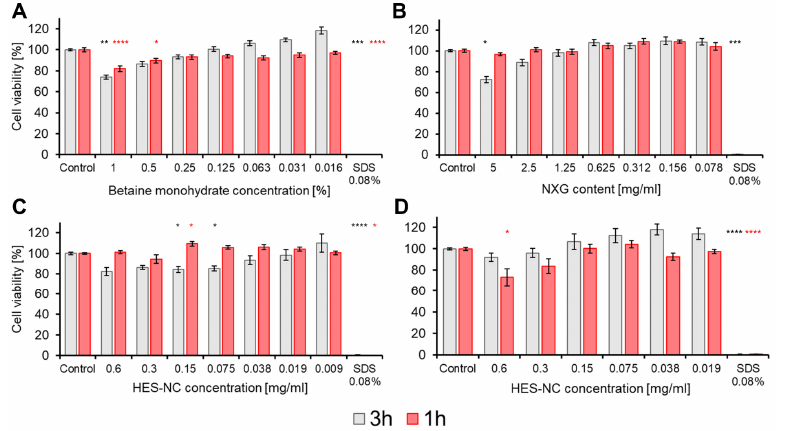
Figure 7. Cell viability as determined by 3-(4,5-dimethylthiazolyl-2)-2,5-diphenyltetrazolium bromide (MTT) assay for ( A ) betaine monohydrate, ( B ) NXG, ( C ) HES-NCs, ( D ) HES-NCs + UVA after 3 h (grey) or 1 h (red) of exposure. Significances in comparison to the control are indicated by asterisks with * = p < 0.05, ** = p < 0.01, *** = p < 0.001, **** = p < 0.0001 as determined by Bonferroni-adjusted post hoc tests after Kruskal–Wallis ANOVA. Mean values ± SEMs of n = 6 to 21 samples are presented.